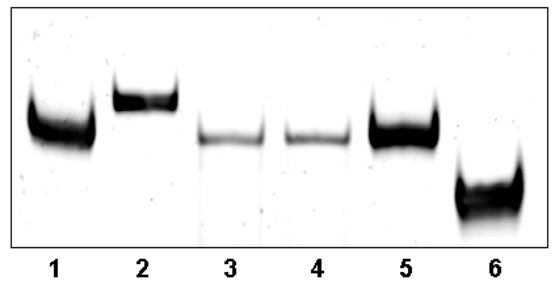
Figure 3. Digestion of the phosphorylated strand of dsDNA with 25 U lambda exonuclease after PCR with 1 ng template per